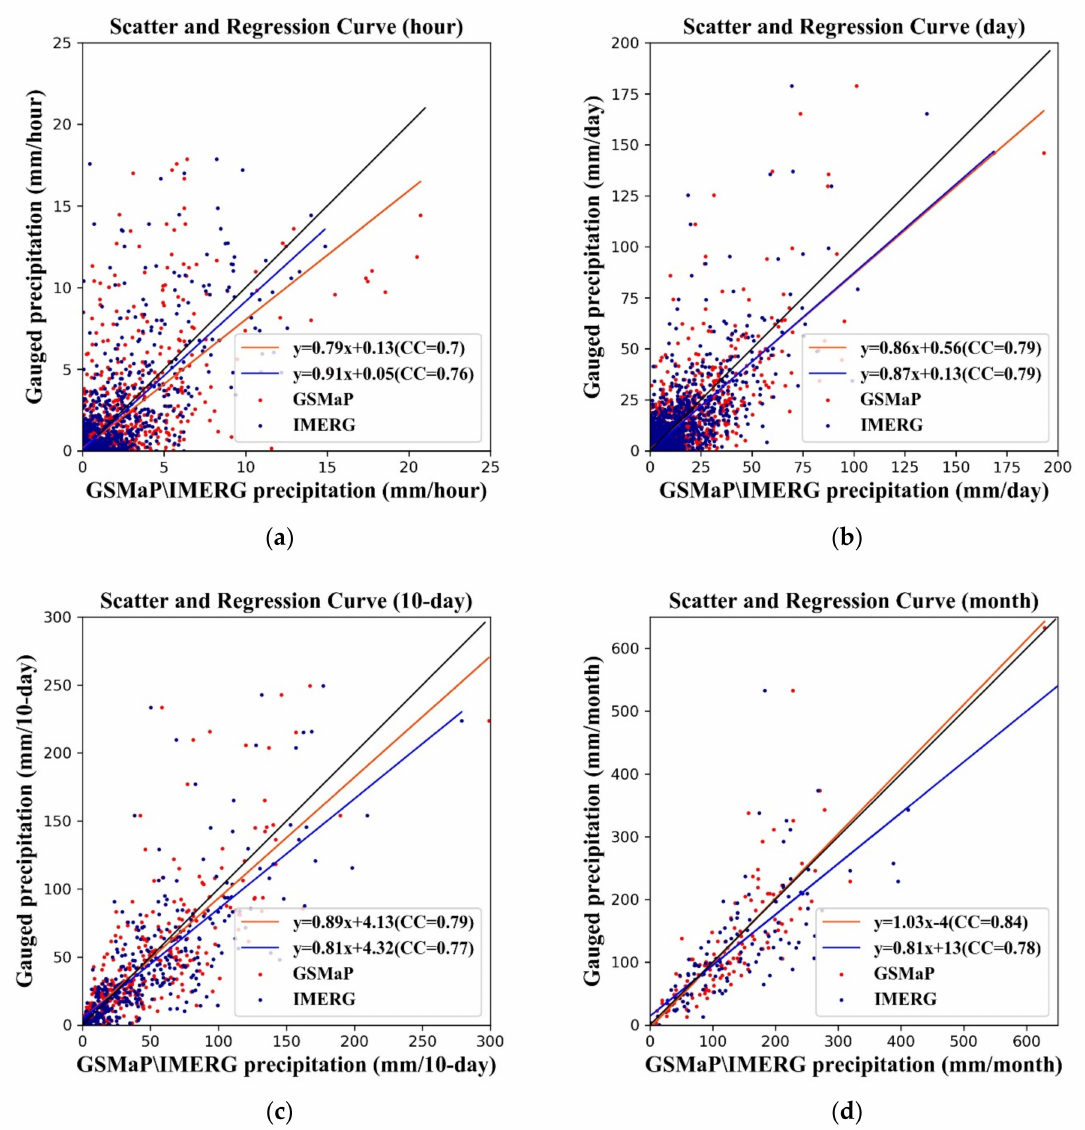
Figure 3. Scatterplots and regression lines from the original Satellite Precipitation Products (SPPs) and gauges with different temporal scales. ( a ) hourly, ( b ) daily, ( c ) 10-day, ( d ) monthly. Blue lines and dots denote Integrated Multi-satellite Retrievals (IMERG) Early data, while red lines and dots represent Global Satellite Mapping of Precipitation-Near Real Time (GSMaP-NRT) data, and the black line is the equal